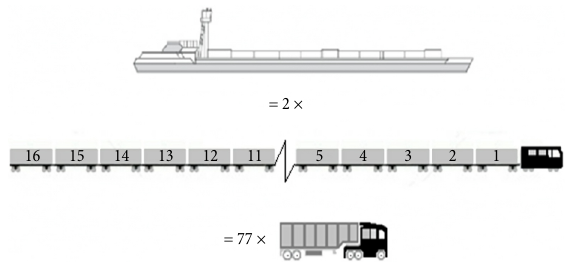
Fig. 4. Number of vehicles for payload